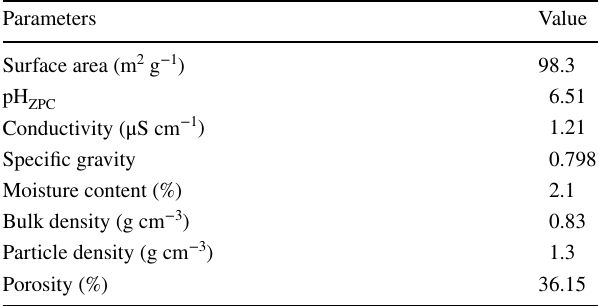
Table 1 The physicochemical characteristics of EGP